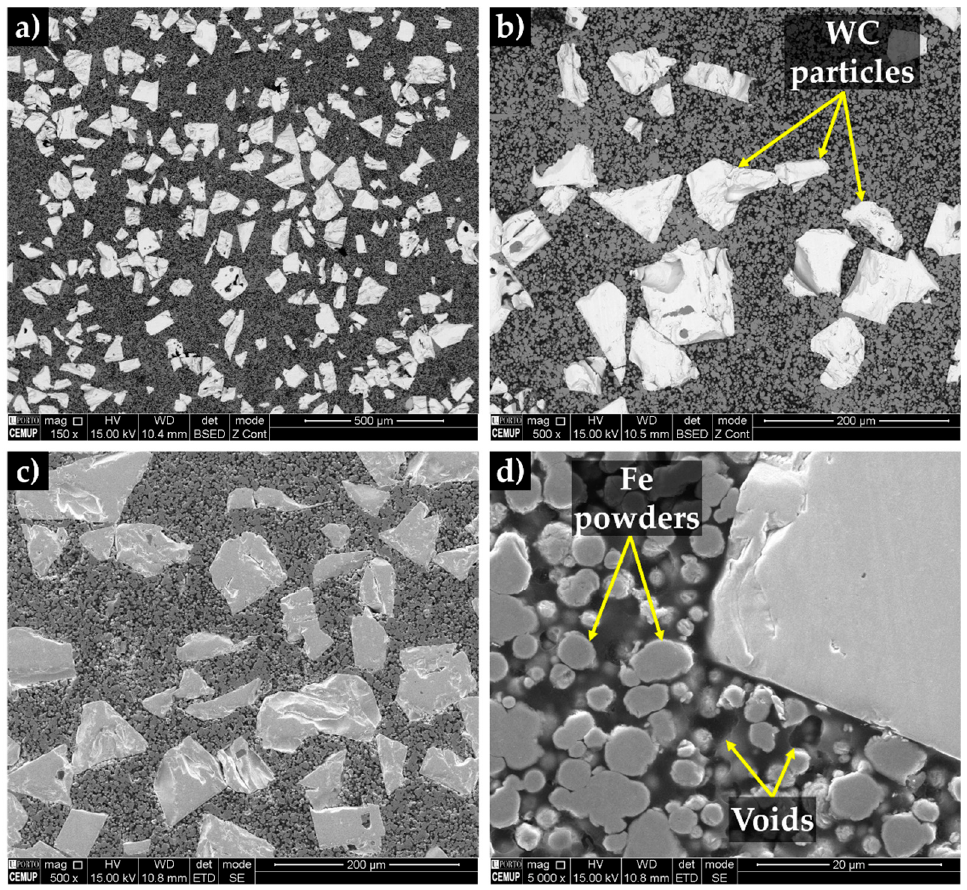
Figure 6. SEM cross-section images of the green compacts: ( a ) low, ( b and c ) medium and ( d ) high magnification.